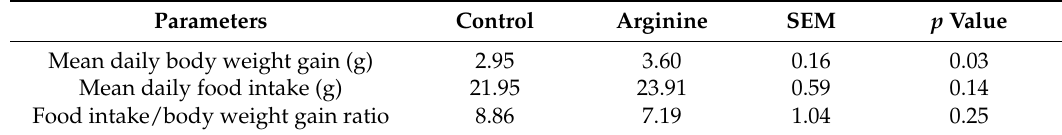
Table 1. Effects of arginine supplementation on body weight gain and food intake of rats ( n =